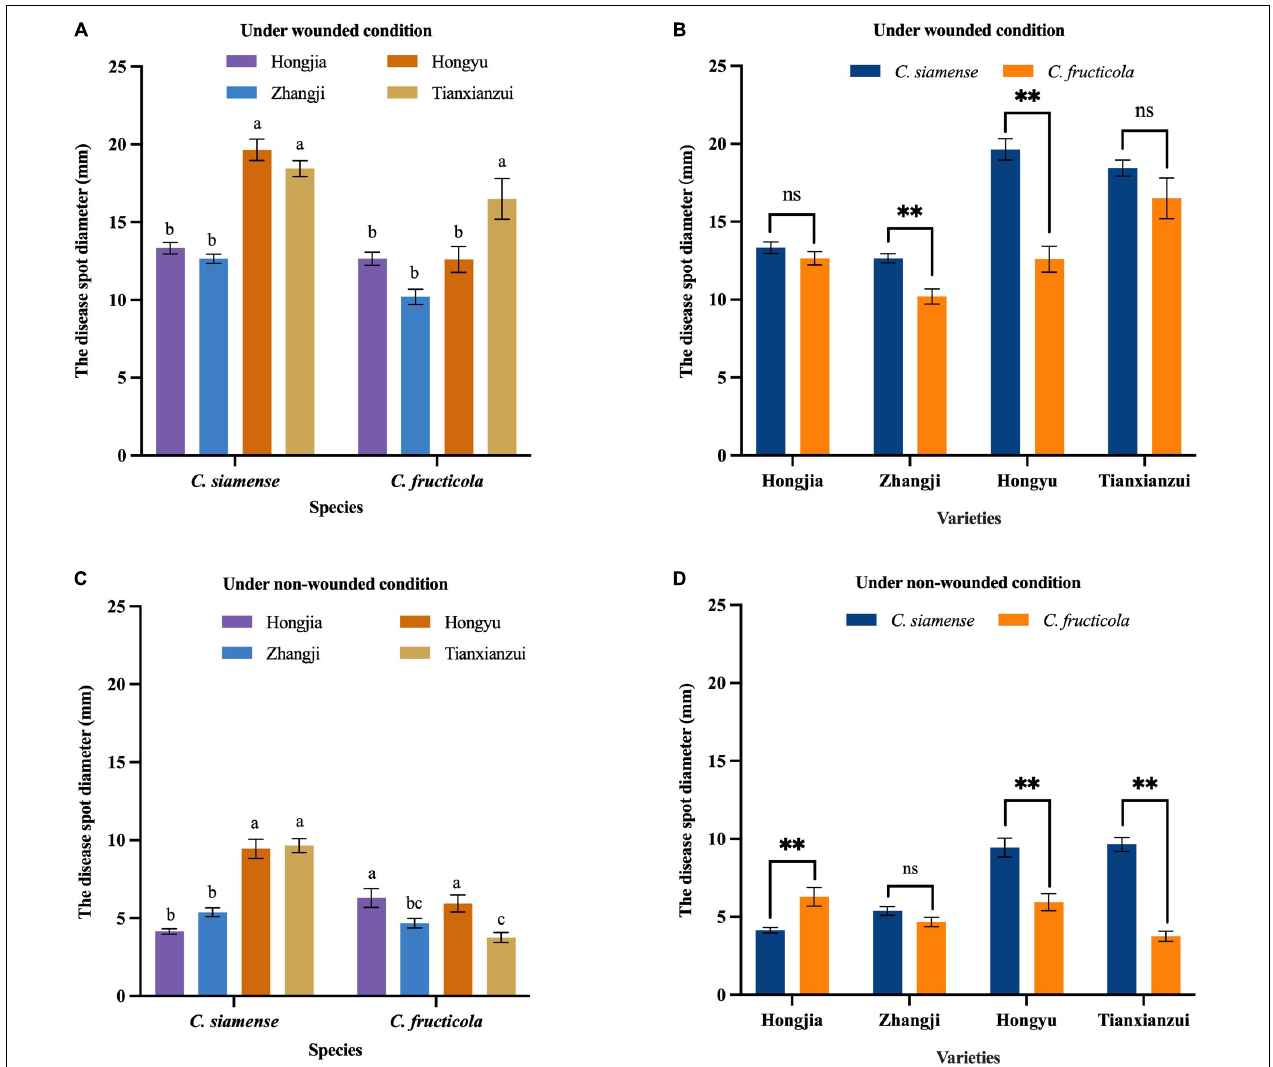
FIGURE 3 | Pathogenicity of Colletotrichum fructicola and C. siamense to different varieties of leaves. ∗∗ P = 0.01, ns = not significant. (A,B) To strawberry leaves of different varieties under wounded condition. (C,D) To strawberry leaves of different varieties under non-wounded condition. Values with the same letters were not statistically different ( P > 0.05) according to the least significant difference (LSD)